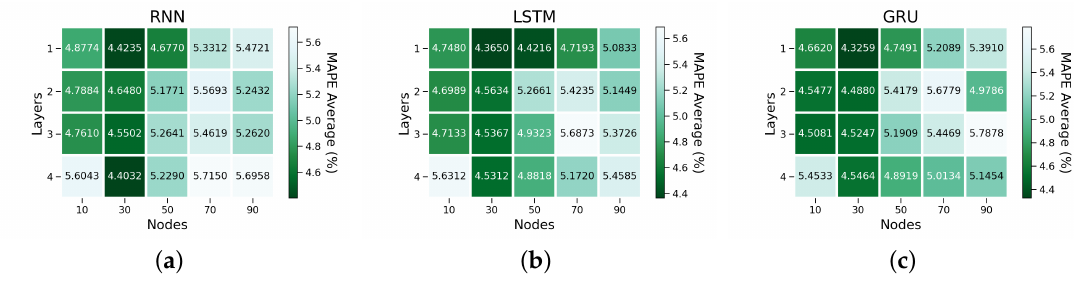
Figure 4. Mean absolute percent error (MAPE) grid search result for ( a ) simple RNN, ( b ) LSTM, and ( c )